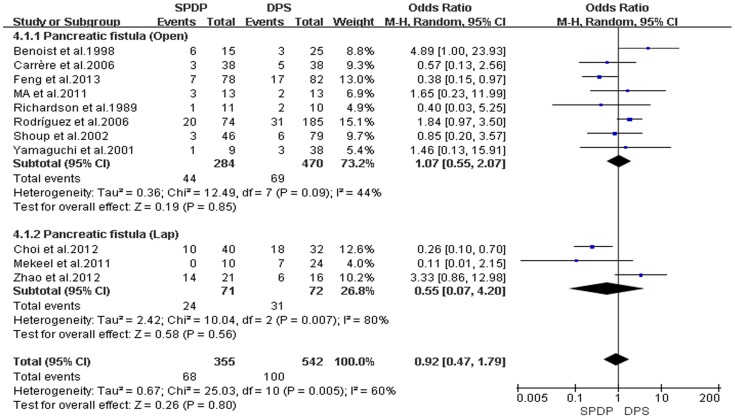
Pancreatic fistula (IV, Inverse variance; M-H, Mantel-Haenszel; CI, Confidence Interval; SD, standard deviation).